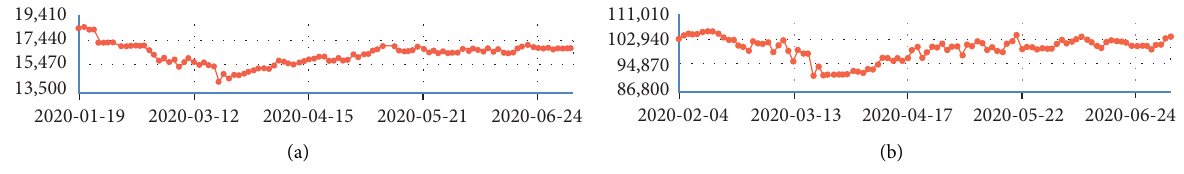
Figure 12: The fluctuation of main spot price of zinc and nickel at the Shanghai stock exchange. (a) Zinc. (b) Nickel.